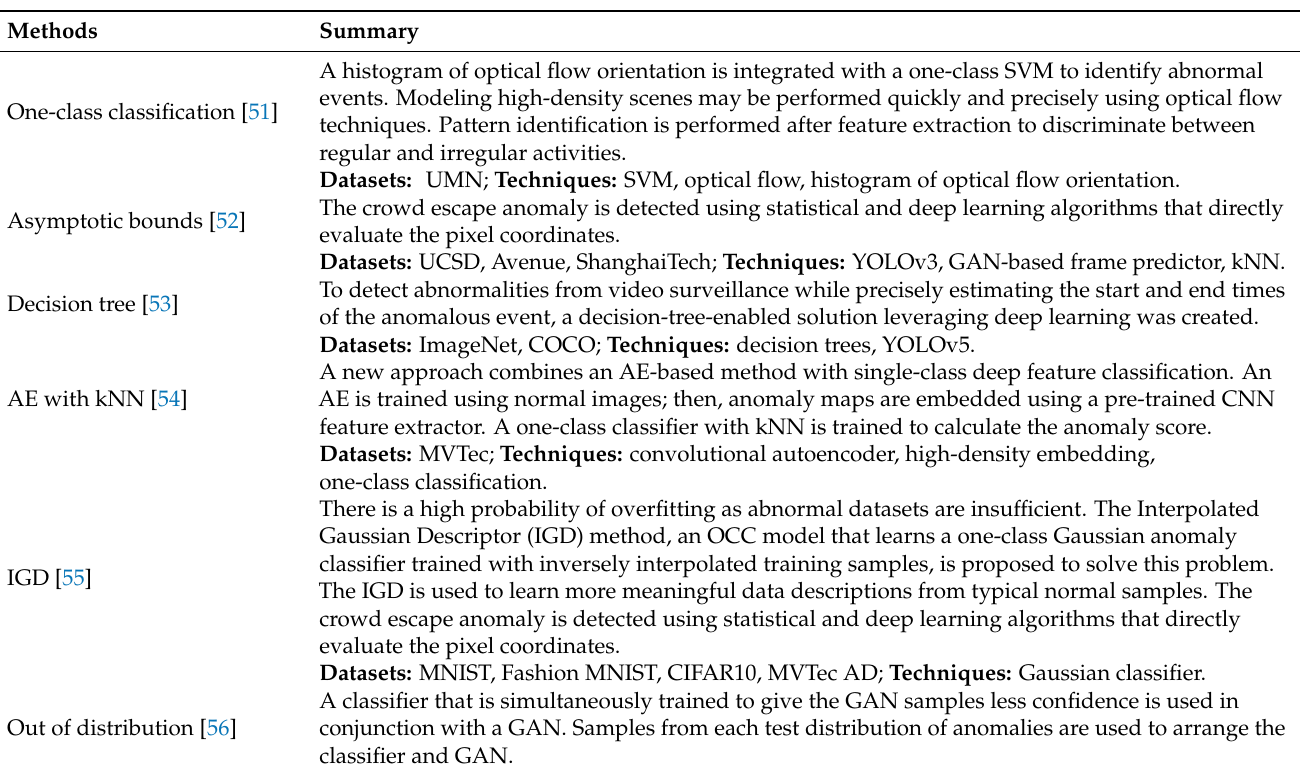
Table 3. Classification-based